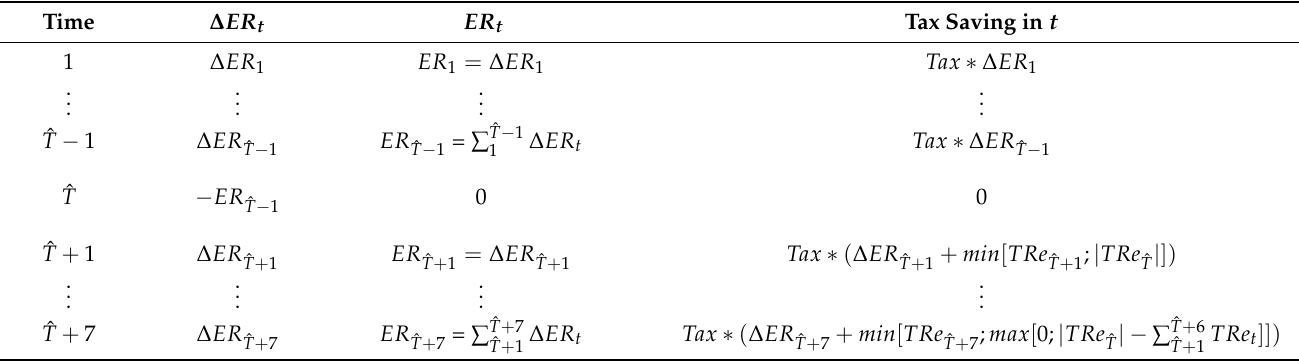
Table 1. Illustration of the impact of taxes from equalization reserves on the net